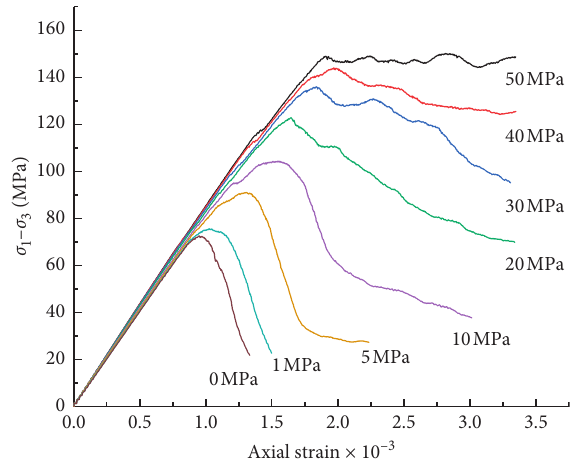
Figure 5: Stress-strain curves of rocks with an elliptical crack under different confining